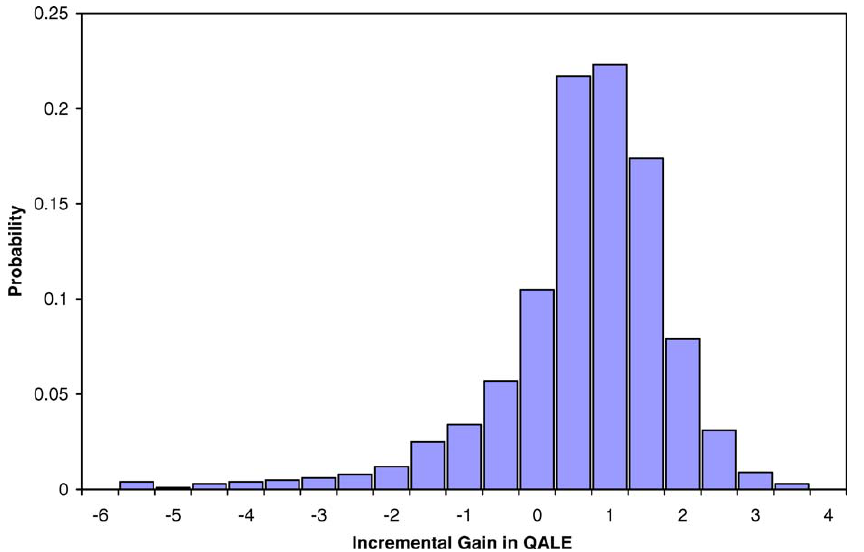
Figure 5. Incremental QALE Gains for the Base Case The histogram depicts the distribution of results of 1,000 Monte Carlo simulations for 60-y-old male patients without comorbidity. Positive values indicate a larger QALE for immediate cystectomy as compared to conservative therapy. The distribution is skewed to the left.